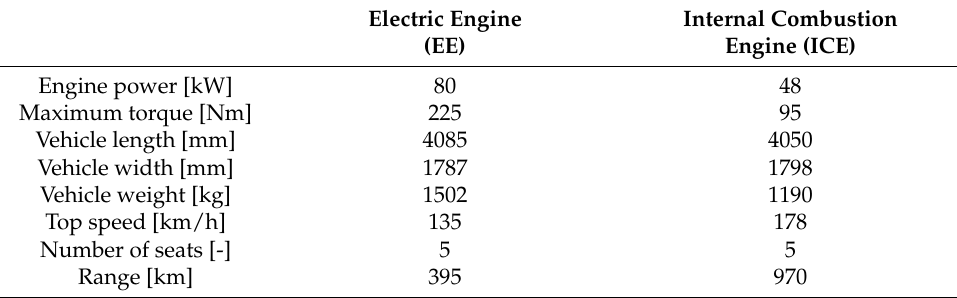
Table 1. Characteristics of the vehicles used in the experiment.